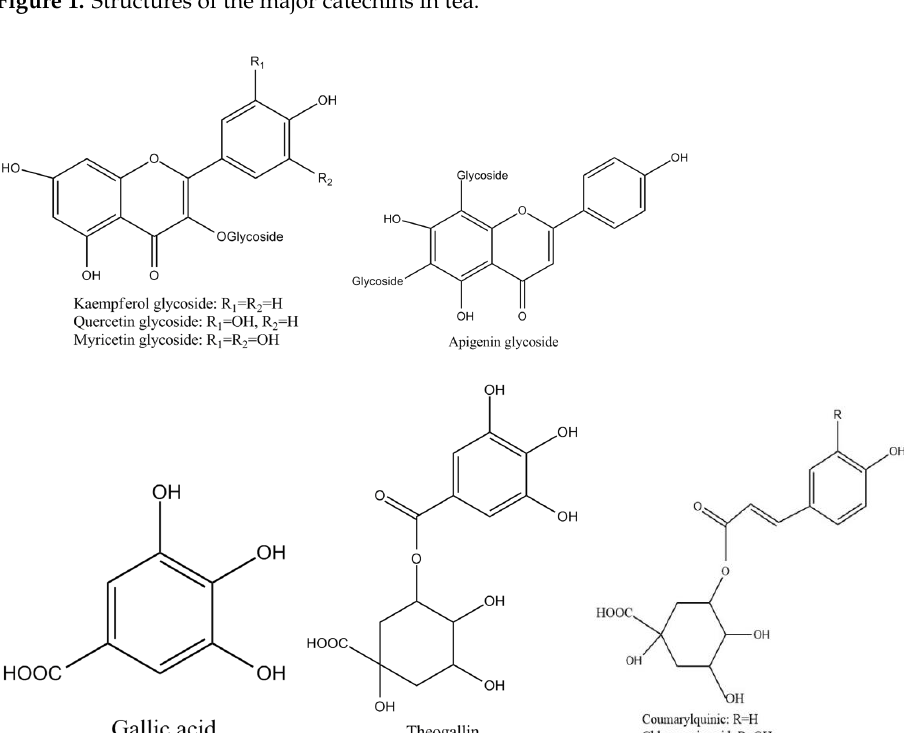
Figure 2. Structures of the major polyphenol compounds in tea.